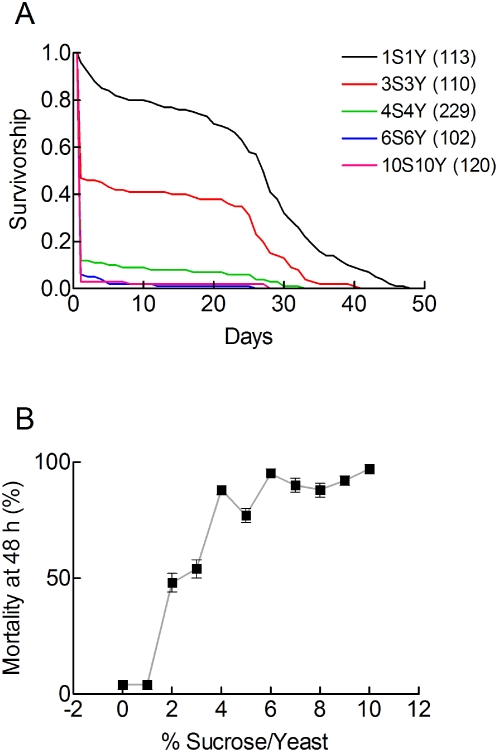
Diet dependent anoxic tolerance.Male w1118 flies were adapted for 2 days to nutrient media that consisted of equal amounts of yeast and sucrose, exposed to 3.5 h of anoxia, reoxygenated and switched to a 10S10Y diet for the rest of their lives. A. Survivorship curves. Note that different dietary conditions mainly changed the short term mortality and that the maximum longevity was less affected. Sample sizes are indicated in parentheses. B. Influence of serial dilutions of a 10S10Y nutrient medium on A/R induced mortality. The total number of flies used was 1501. Sample sizes were 103 to 229. Means±sem are indicated.